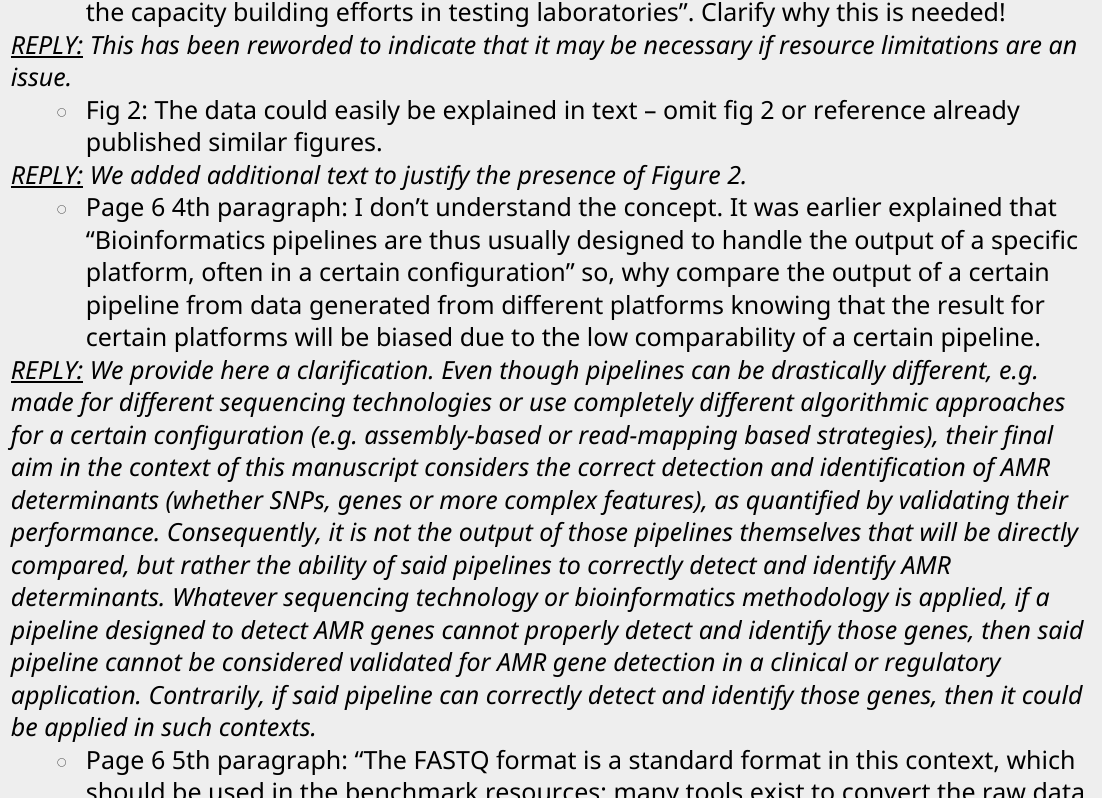
Page 6 2nd paragraph: “in practice, a prioritisation exercise should be made based on